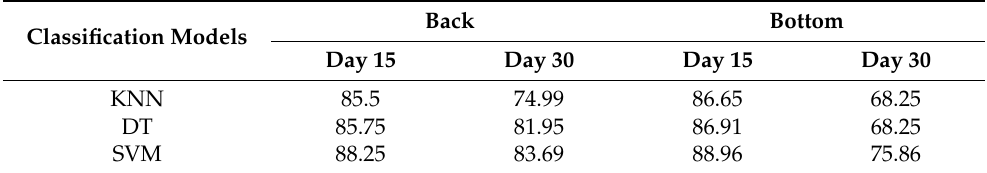
Table 1. OA (%) for different classification models for different mildew situations. Classification